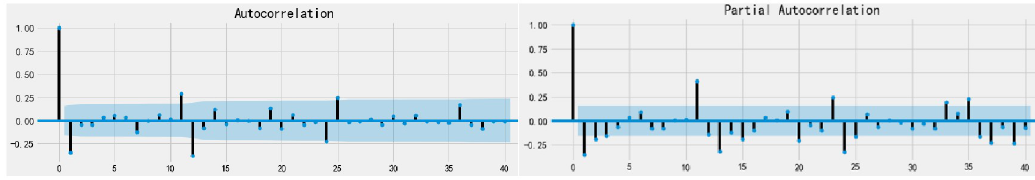
Fig 4. ACF and PACF of the sequence after 1-order12-step difference. The analysis of ACF and PACF shows that both the Autocorrelation Coefficient and the Partial Correlation Coefficient within the 12 steps are trailing, so p = 1 and q = 1 are used to extract the short-term autocorrelation information of the differential sequence. According to the autocorrelation and partial autocorrelation characteristics of the model, it is considered that the seasonal autocorrelation characteristics are the truncation of autocorrelation coefficient and the partial autocorrelation coefficient is tailing. Therefore, ARMA (0,1) 12 model with a 12-steps- cycle is used to extract the seasonal autocorrelation information of the difference sequence. Then the AIC criterion is used to evaluate the selected model. Through grid search and according to AIC criterion, the optimal model is SARIMA (1,1,1) (1,1,1) 12 , and the AIC value is the lowest, which is 2996.15.